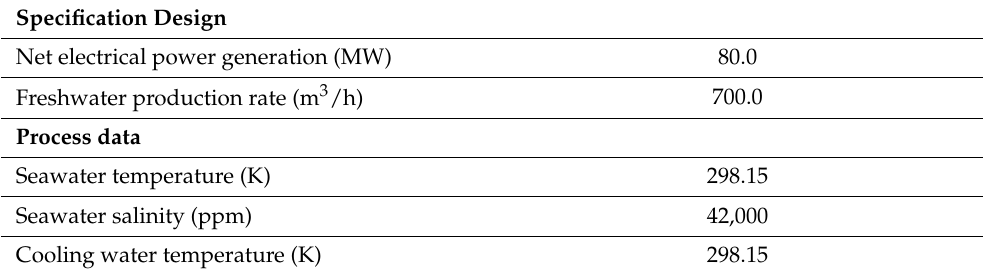
Table 1. Main parameter values.